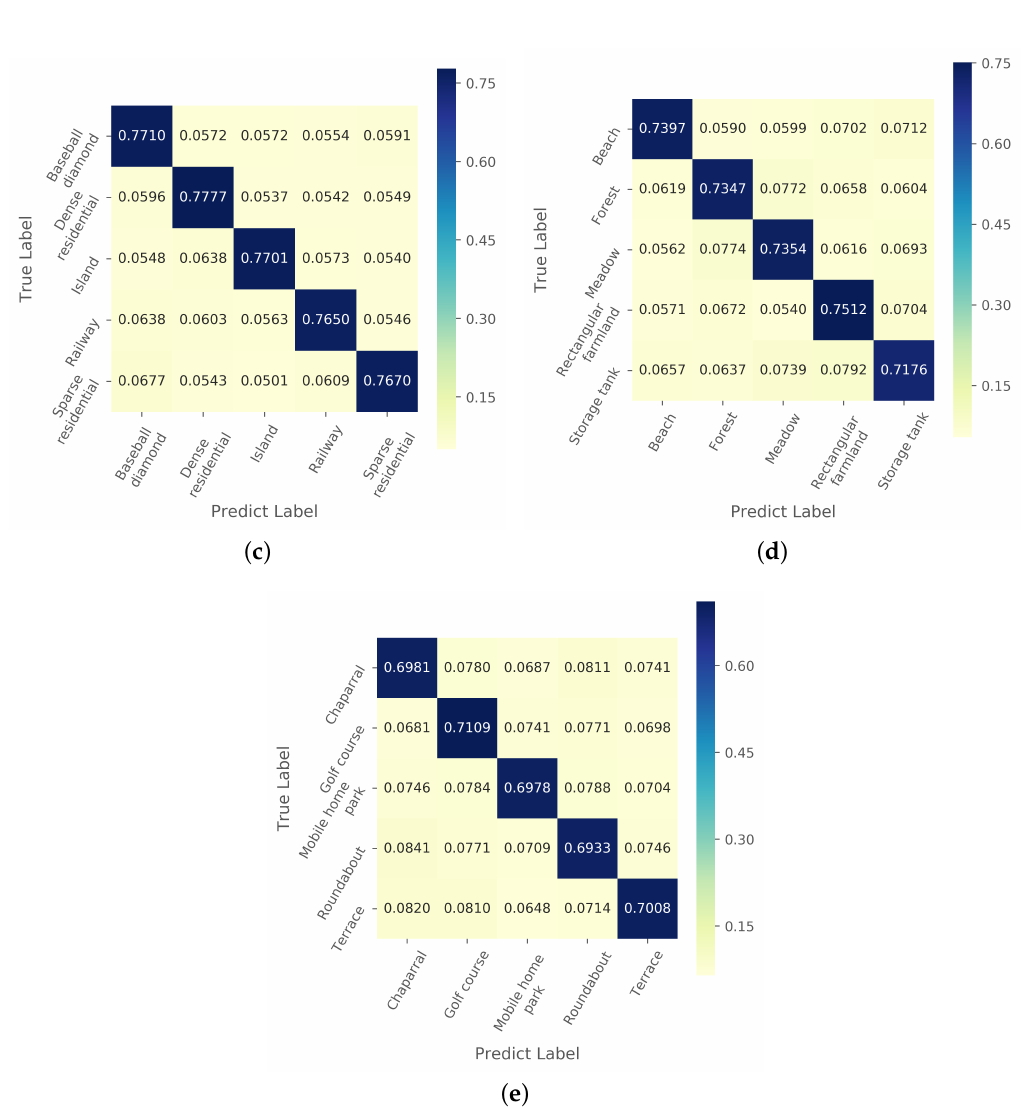
Figure 10. Confusion matrix ofAMN results on 600 randomly selected tasks on the NWPU-RESISC45 dataset. ( a – e ) confusion matrix of text results on experiment